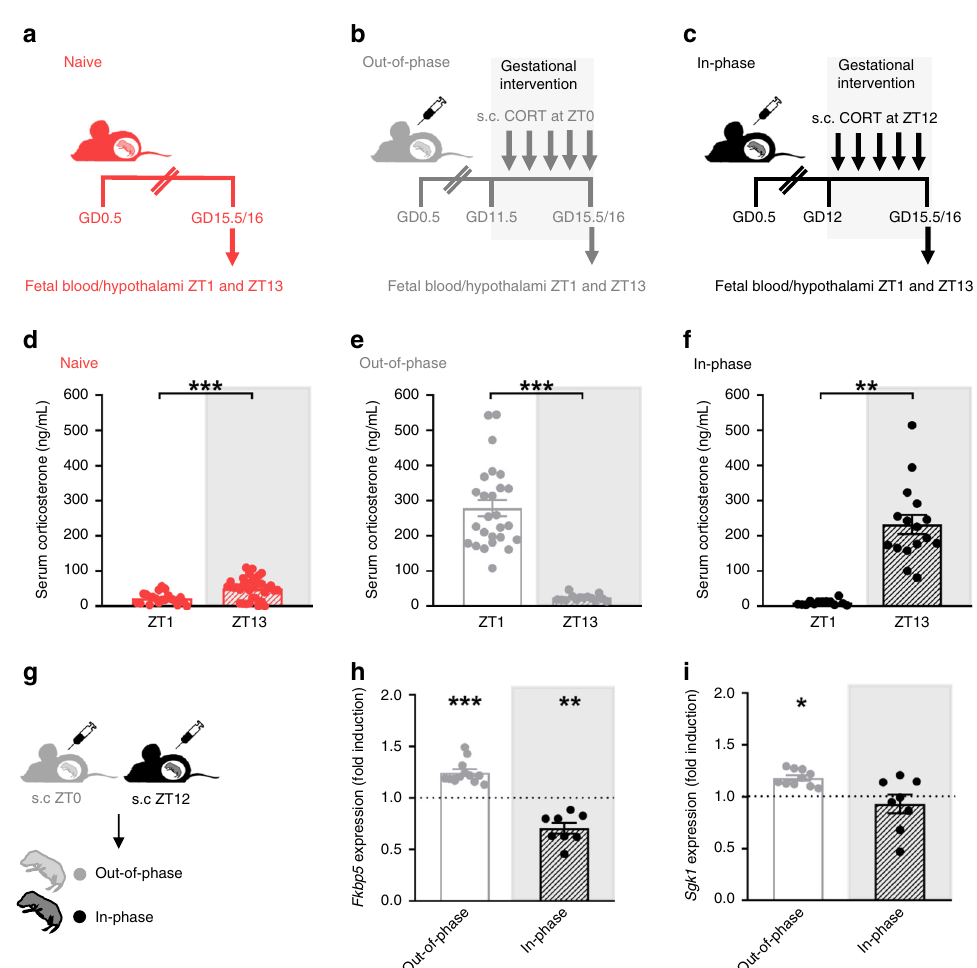
Fig. 3 Fetal hypothalamic GR transcriptional activity is diurnally regulated. a – c Scheme of the prenatal timed corticosterone (CORT) intervention. Mothers were left undisturbed ( a ) or injected subcutaneously (s.c) with CORT at Zeitgeber time 0 (ZT0, 6 a.m) ( b ) or at ZT12 (6 p.m) ( c ) from gestational day (GD 11.5). On GD 15.5 – 16.5 fetal blood and hypothalami were collected at ZT1 and ZT13. d Corticosterone levels in fetal serum from undisturbed mothers at ZT1 and ZT13 ( n = 20 ZT1 and n = 33 ZT13). e Corticosterone in fetal serum from mothers injected at ZT0 (out-of-phase, n = 26 ZT1 and n = 14 ZT13) and f Corticosterone in fetal serum from mothers injected at ZT12 (in-phase, n = 13 ZT1 and n = 16 ZT13). Corticosterone measurements were done in duplicates. g Scheme of the prenatal timed CORT intervention, the fetal hypothalamus was dissected 1 h after maternal injection. h , i mRNA relative expression of the glucocorticoid receptor (GR) targets FK506 binding protein 5 ( Fkbp5 ) (h) and Serum glucocorticoid-regulated kinase 1 ( Sgk1 ) (i) in the hypothalamus of fetus from wild-type mothers. For h and i gene expression is shown as fold induction after CORT treatment (at ZT0 or ZT12) relative to naive fetus (dotted line) ( n = 9 naive ZT1, n = 12 out-of-phase ZT1, n = 12 naive ZT13, n = 8 in-phase ZT13). qPCRs for gene expression were run in duplicates. Data are expressed as means ± SEM. Differences of corticosterone levels at both time points ( d – f ) and fold induction after CORT injection ( h , i ) were analyzed by two-sided unpaired t -test d t = 3.89, df = 51, p = 0.0003; e t = 8.15, df = 38, p < 0.0001; f t = 7.313, df = 27, p < 0.0001; h Fkbp5 : Naive ZT1 vs out-of-phase ZT1 t = 3.44, df = 19, p = 0.0027; Naive ZT13 vs in-phase ZT13 t = 4.39, df = 18, p = 00003. i Sgk1 : Naive ZT1 vs out-of-phase ZT1 t = 3.29, df = 17, p = 0.0043. * p < 0.05, ** p < 0.01, *** p < 0.001. Source data are provided as a Source Data fi Fetal hypothalamic rhythms of GR and REVERB α are anti- phasic . If the fetal clock would differentially regulate GR tran- scriptional activity depending on the time of day, four levels of fetal clock-dependent control appear possible: rhythms in GR (Supplementary Fig. 3b, c). expression, in GR availability, in GR activation or in GR binding to GC regulatory elements (GREs). Amongst the GR-regulating clock proteins described so far 12,15 – 18 , REVERB α would be a Fetal clocks control GC sensitivity by rhythmic REVERB α . To good candidate because it is the earliest clock protein to oscillate assess whether REVERB α could be the clock protein controlling in the fetal hypothalamus 48 and interacts with the heat shock protein HSP90 and GR in the cytosol to reduce GR stability, its translocation to the nucleus and subsequent activity (Fig. 4a) 17 . Diurnal rhythms of GR and REVERB α were anti-phasic at the protein level in the fetal hypothalamus (Fig. 4b, c). In contrast, no diurnal regulation of Gr was seen at mRNA levels nor for GR ’ s